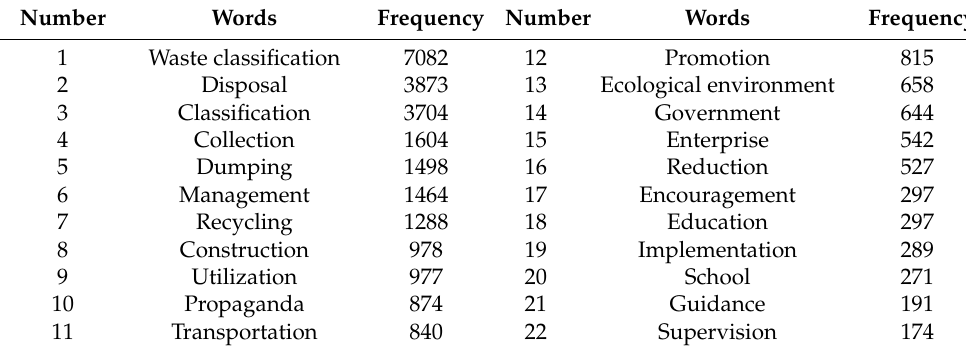
Table 1. The 22 words with the highest